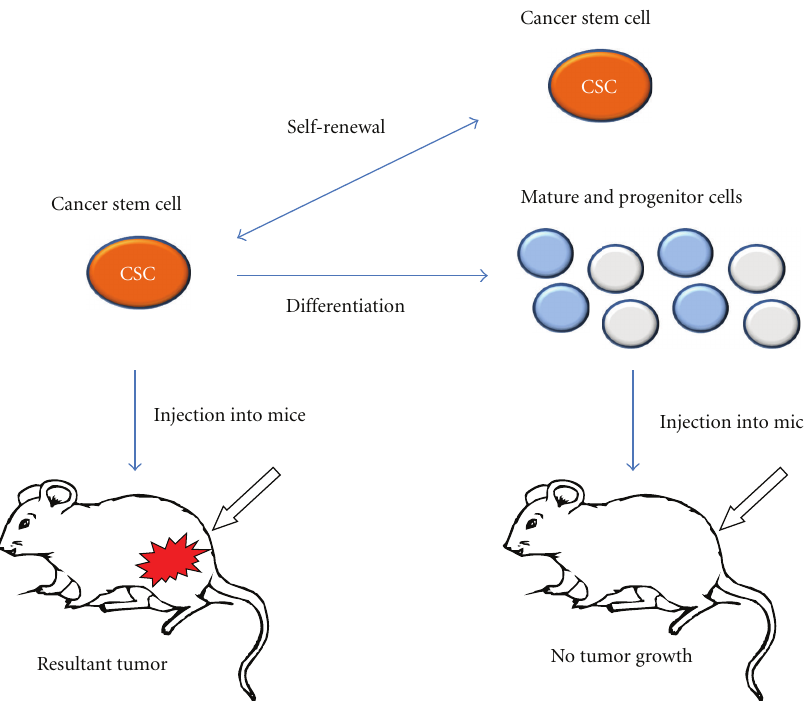
Figure 1: Three phenotypes of CSCs: self-renew, multipotentiality, and tumor-initiating capacity. Self-renewal: single-cell culture sphere- forming assay. Di ff erentiation: flow cytometric analysis of di ff erentiation markers and loss of stem cell markers. Tumor-initiating properties were investigated by injection of CSCs in NOD/SCID mice. The most crucial standard for a CSC is its ability to reinitiate a serially transplantable tumor that recapitulates the original heterogeneity and tumor histology. Using this standard, many so-called CSCs reported so far are based on correlative studied rather than being true